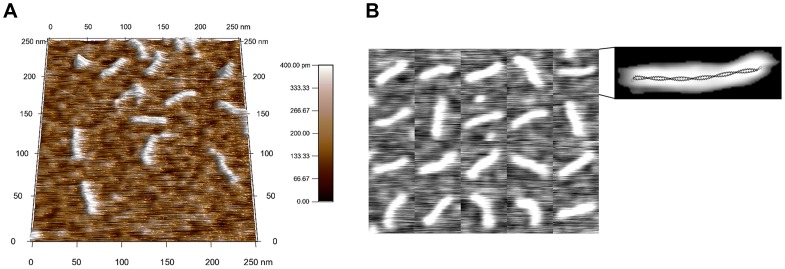
AFM images of α-tropomyosin (αTm) molecules.Wildtype human cardiac αTm was imaged dry on poly-lysine coated mica (A). Collage of 20 αTm molecules (B) show that molecular contours were smooth and continuous. One of the αTm molecules in the collage was processed as described (Figure 2 C) and overlayed with the x-ray structure of αTm [38] on the same scale (B, expanded on right), which is evidence that the AFM images were good representations of single αTm molecules.